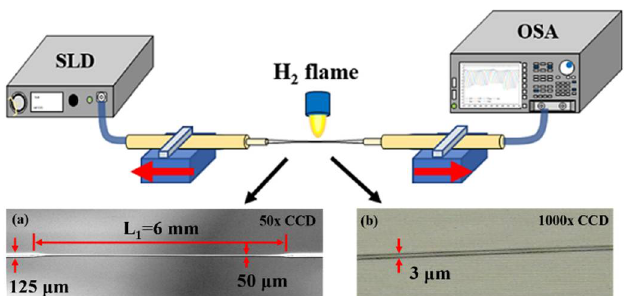
Figure 1. Experimental set-up of the strain sensor using an elongated abrupt taper;( a ) microphoto- graph of a 50 × CCD microscope and ( b ) microphotograph of a 1000 × CCD microscope.